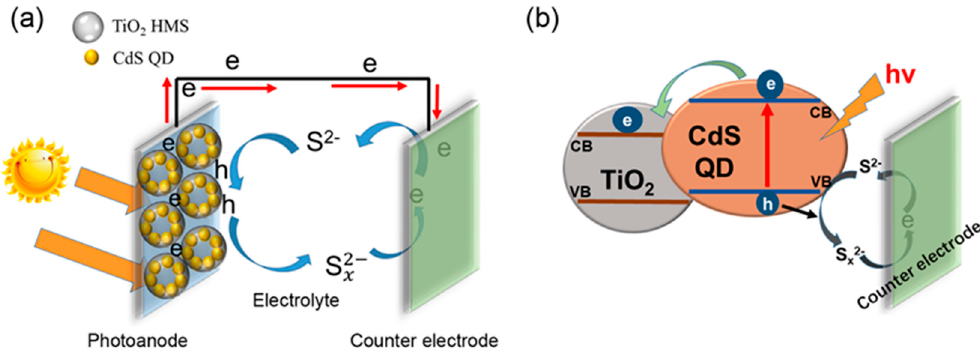
Figure 6. ( a ) The working model of ZnS/CdS@TiO 2 HMS QDSSC; ( b ) the charges transport mechanism in ZnS/CdS@TiO 2 HMS QDSSC.